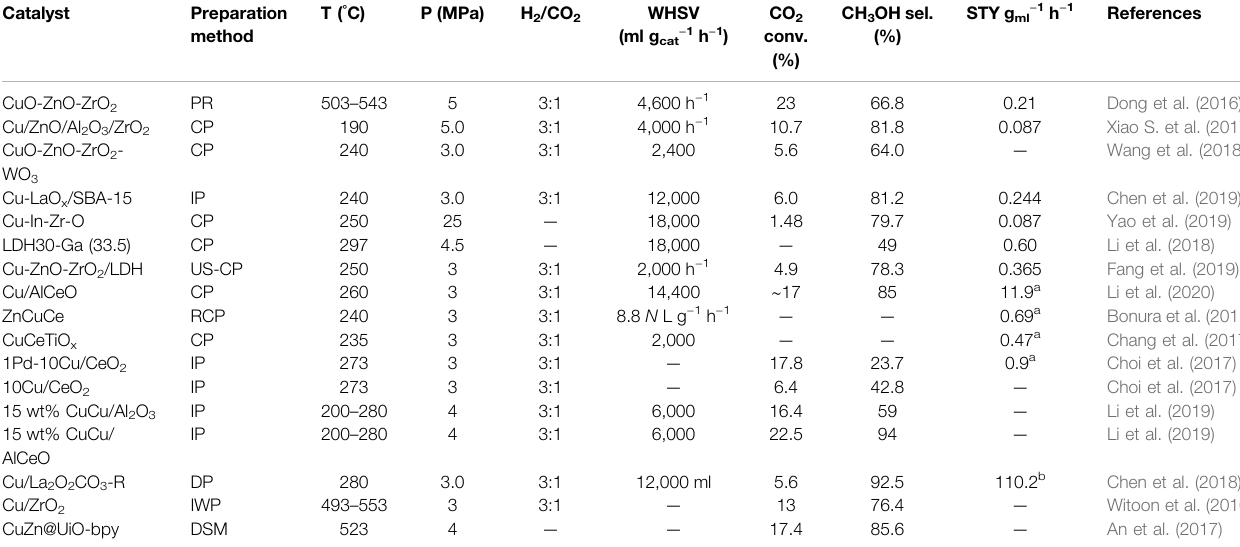
TABLE 3 | Catalytic activities of recently studied Cu-catalysts for methanol synthesis from CO 2 hydrogenation in fi xed bed reactors. Catalyst Preparation